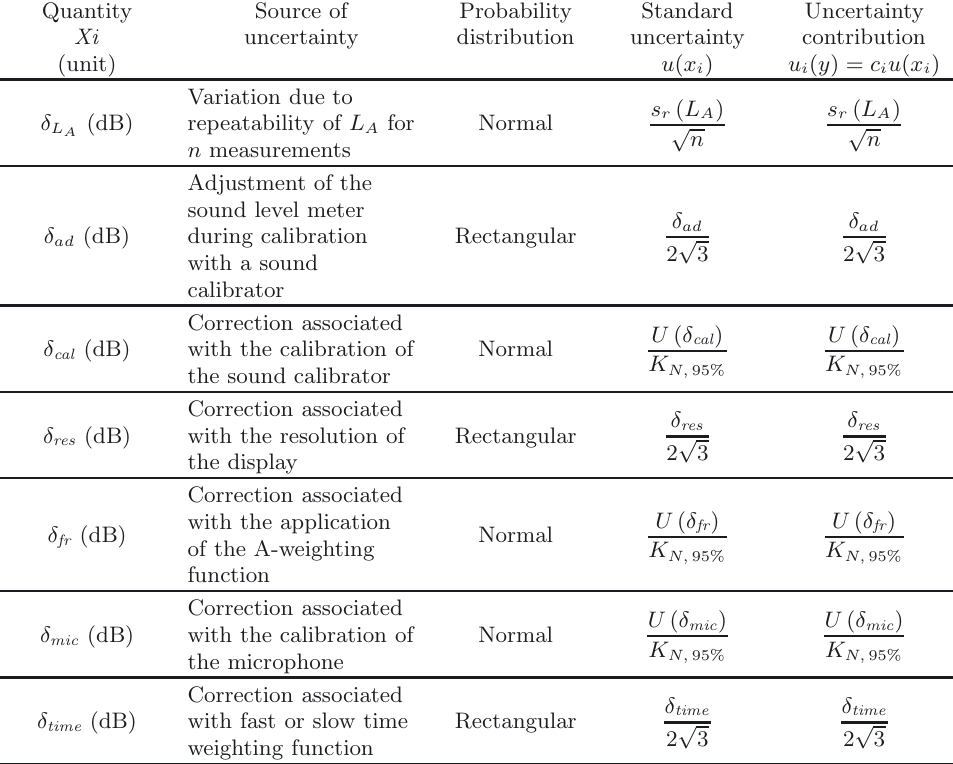
Table 3. Uncertainty budget for sound pressure level measurements of HVAC-Unit. Quantity Source of Probability Standard Uncertainty Xi uncertainty distribution uncertainty contribution Variation due to